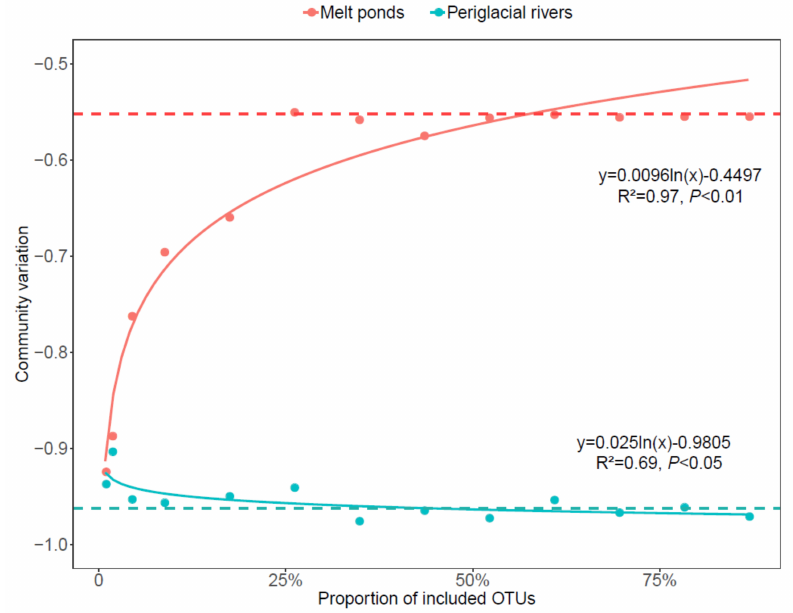
Figure 5. The bacterial community variation (based on Raup-Crick metrics) along a sequence of accumulating rare OTUs in melt ponds and periglacial